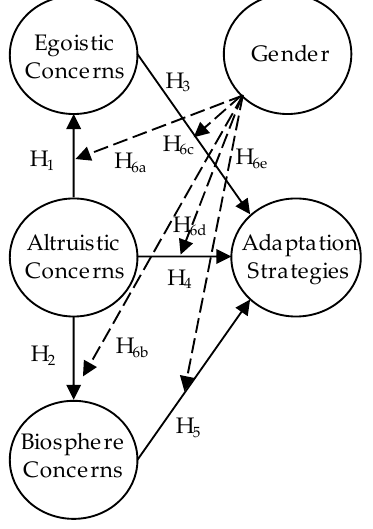
Figure 1. The proposed research model.